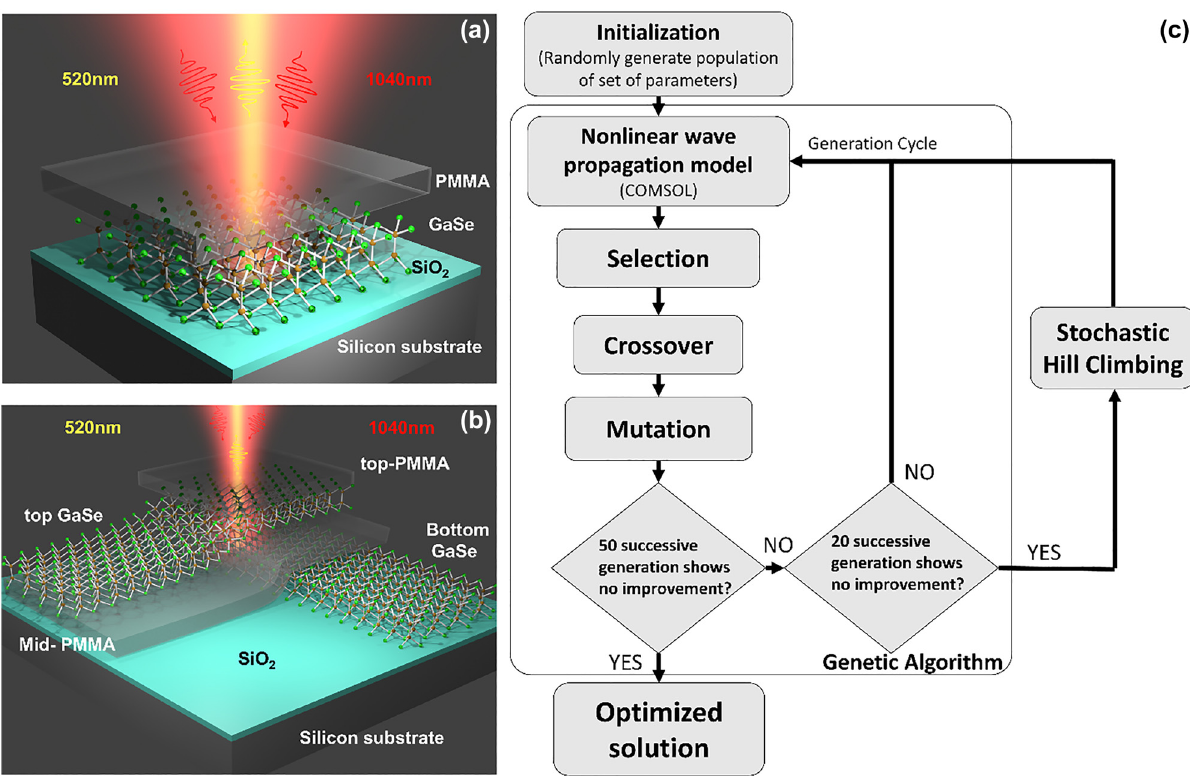
Figure 1: Schematic of: (a) single GaSe FP structure consisting of PMMA encapsulated multilayer GaSe on SiO structure consisting of two multilayer GaSe on top of SiO utilized here for the design combining GA and SHC